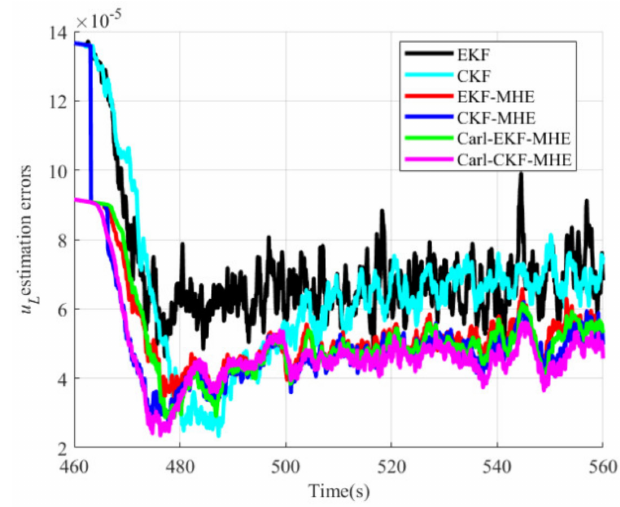
Figure 10. u L estimation